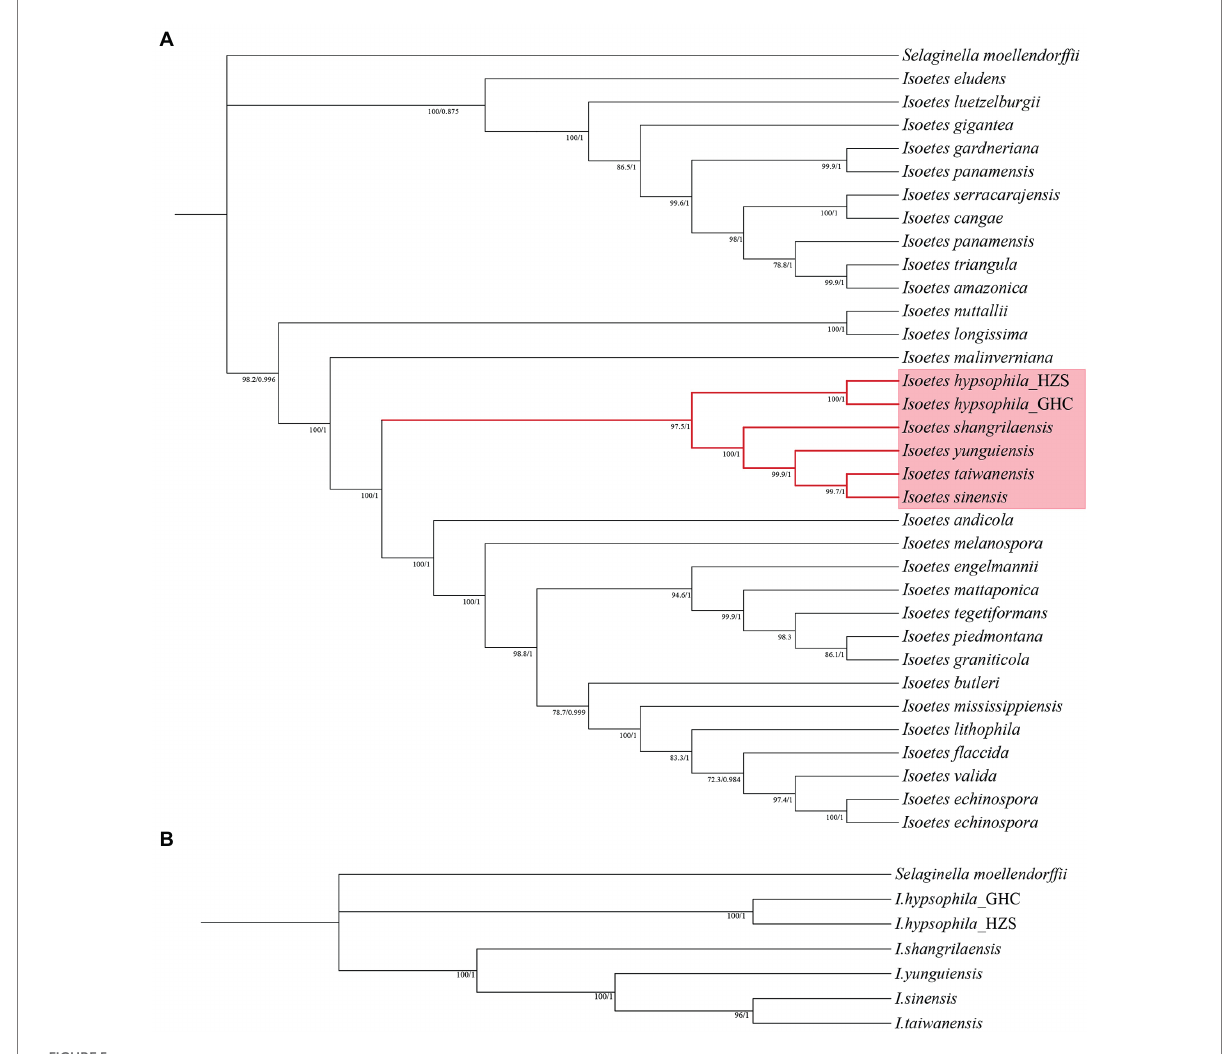
FIGURE 5 (A) Phylogenetic tree constructed using protein-coding regions of the chloroplast genomes. (B) Phylogenetic tree constructed using transcriptome data.